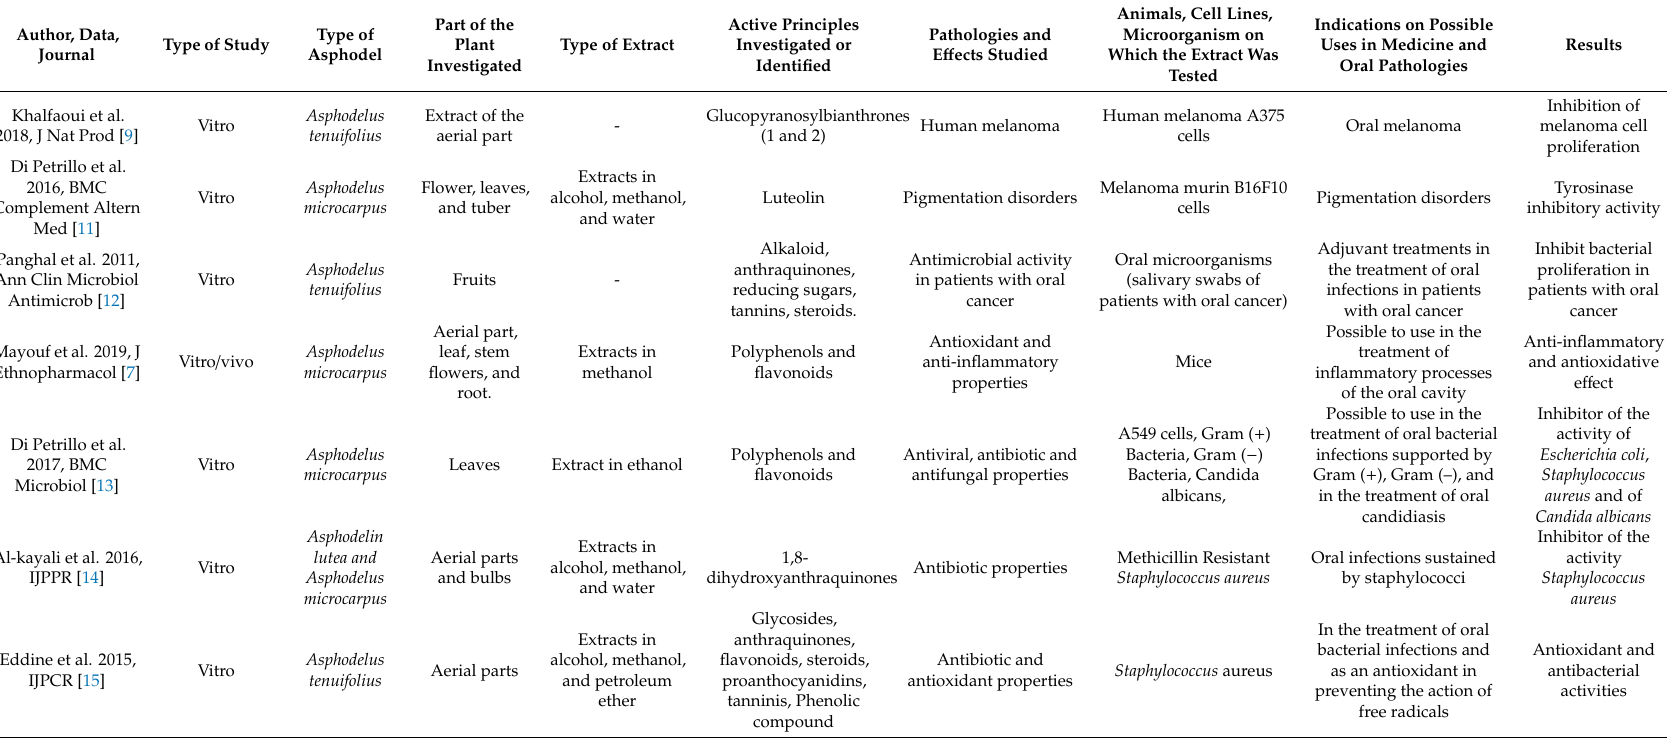
Table 2. The main characteristics of the 11 selected studies are described, with reference to the authors, the year of publication, the variety of Asphodel , the type of extract, and the results